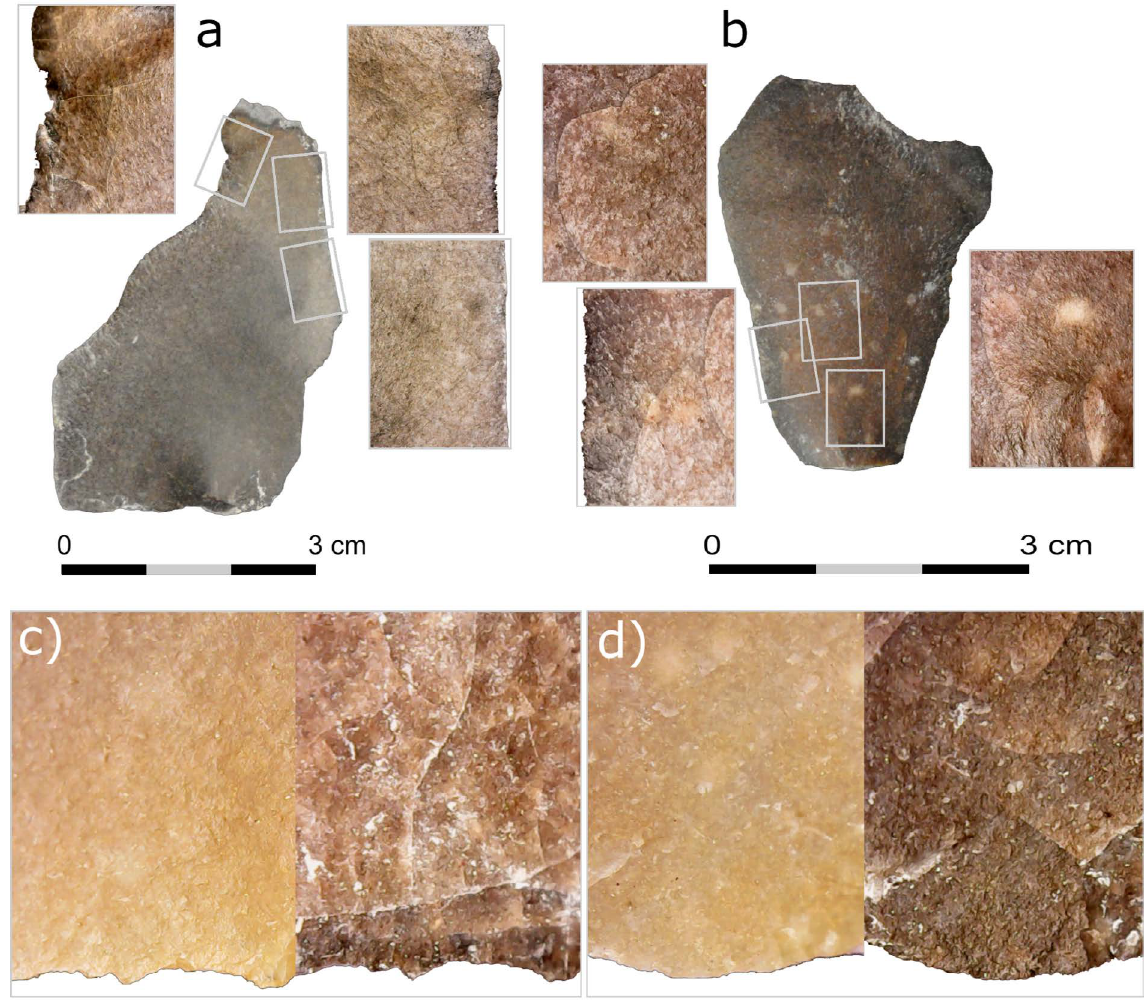
Figure 3. Samples of heat alterations: a) samples of internal cracking on the surface of the blank seen from a macroscopic view; b) development of scales on the surface of the blank seen from a macroscopic view; c) detail photo of the development of internal cracking; d) detail photo of the development of